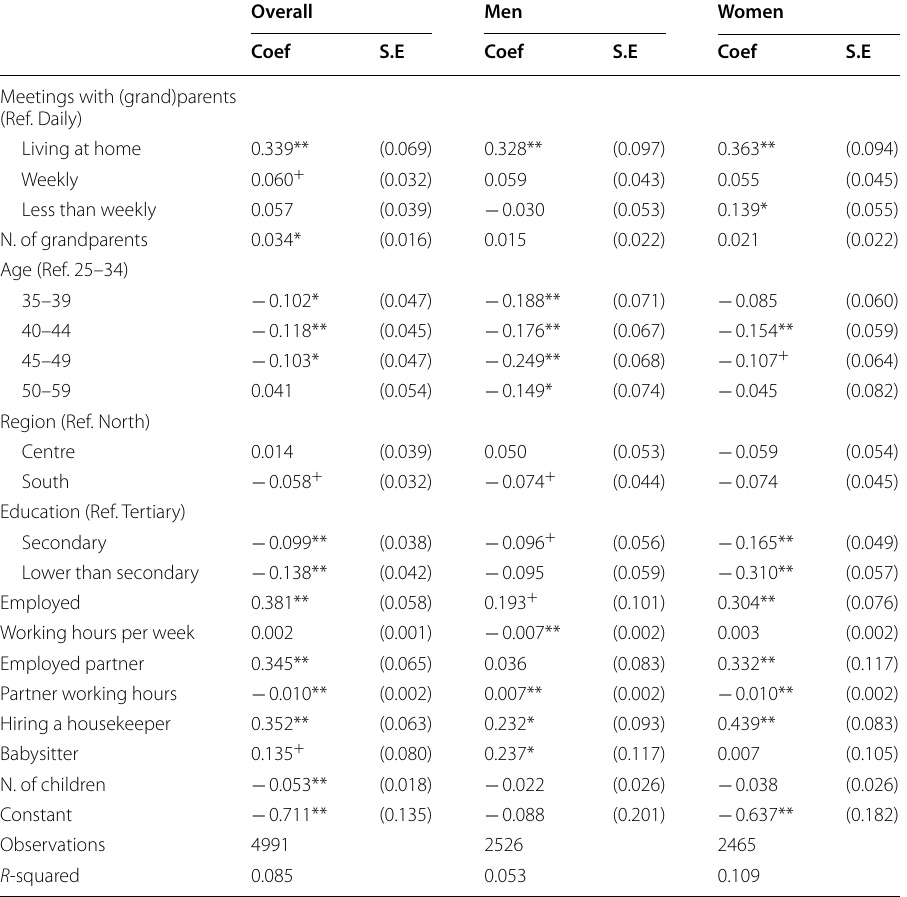
Table 2 Linear regression models on symmetry in the division of housework ( Z